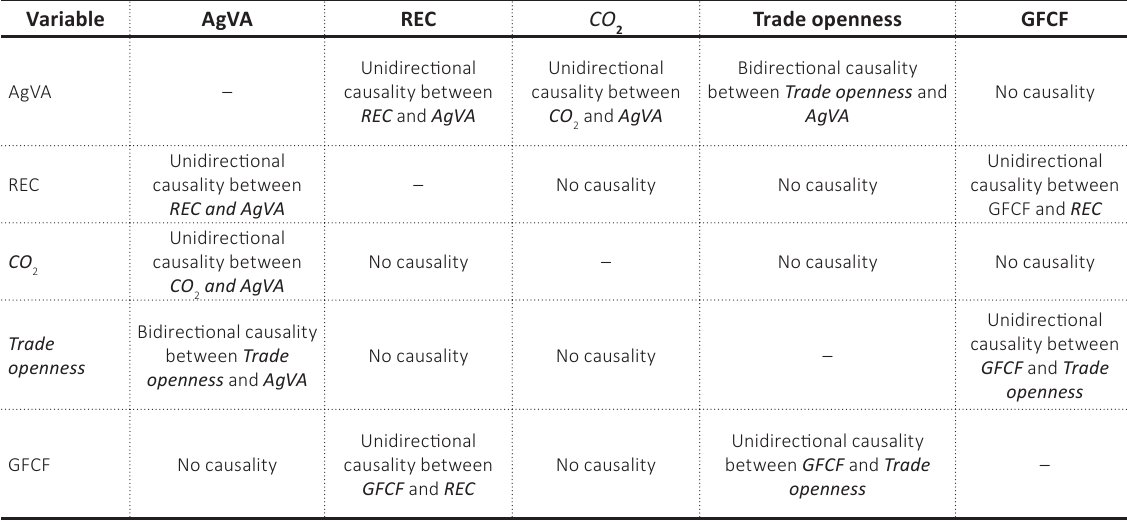
Table 6. Granger causality test